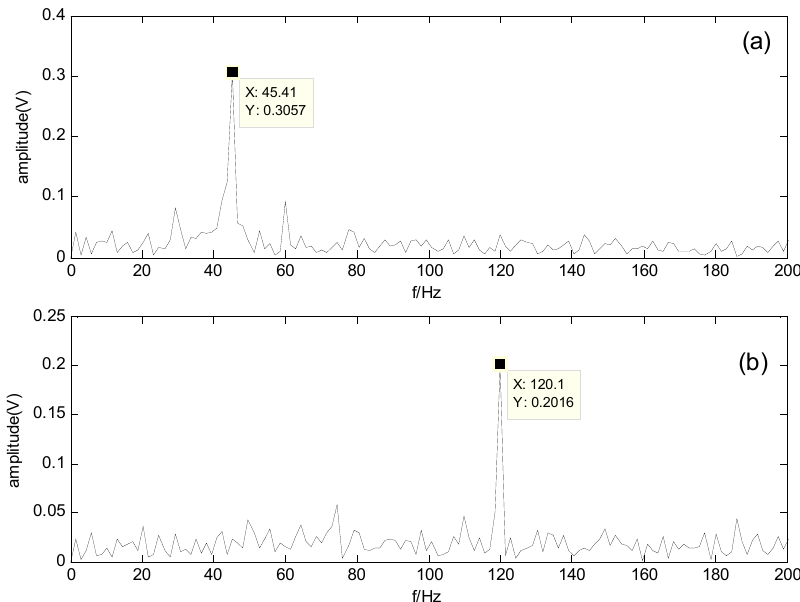
Figure 5. Spectrum of the signals separated by the proposed method: ( a ) Spectrum of IC1; ( b ) Spectrum of IC2.